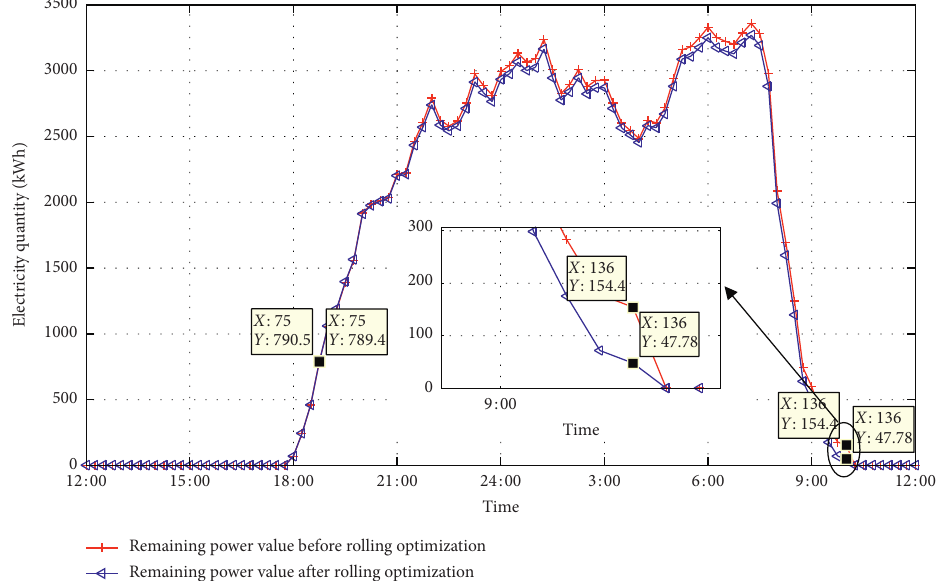
Figure 11: Comparison result of standard function value of global constraint